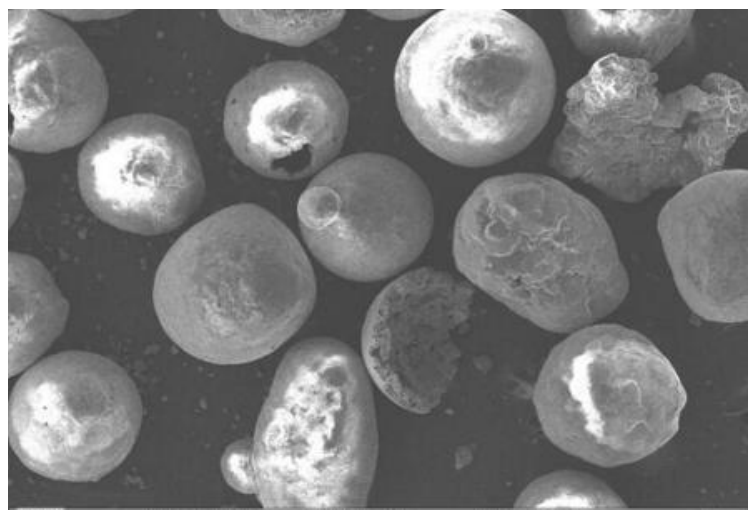
Figure 1. Micrograph of the Al 2 O 3hs .